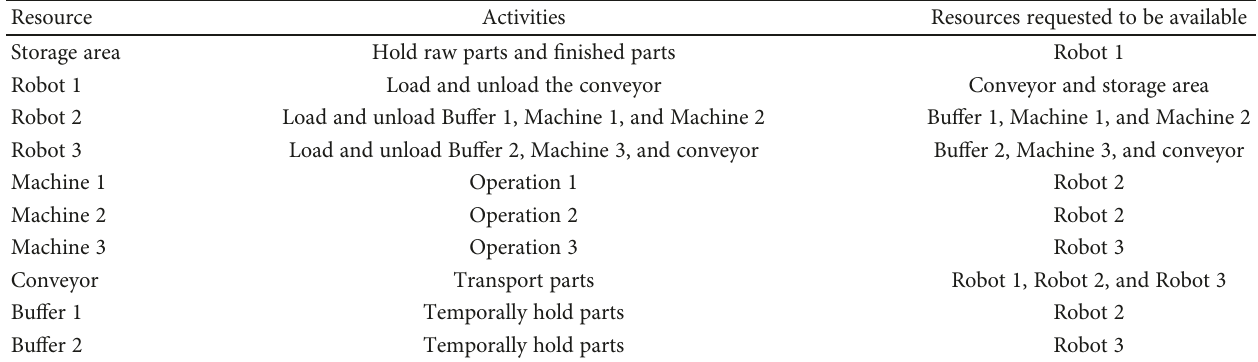
Table 1: Operations of the AMS shown in Figure 1 and the resources